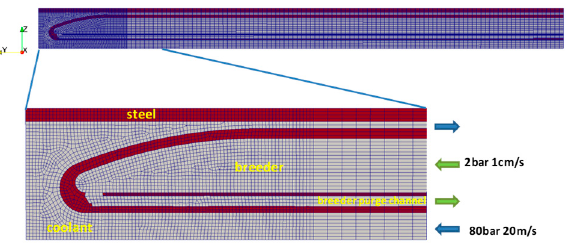
Figure 3. 2D OpenFOAM mesh with boundary conditions (BCs) of helium purge and coolant flow fields.